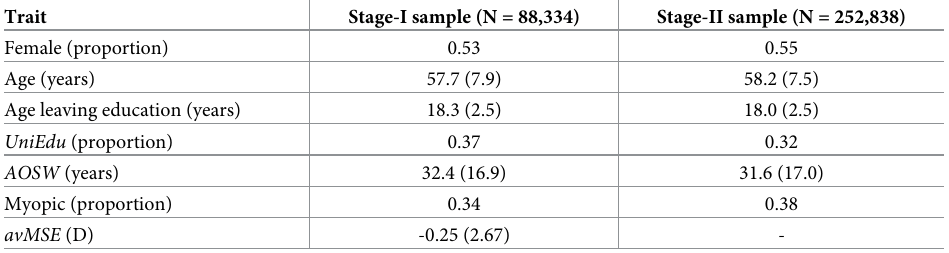
Table 1. Demographic characteristics of the Stage-I and Stage-II samples. Values are means (standard deviations in